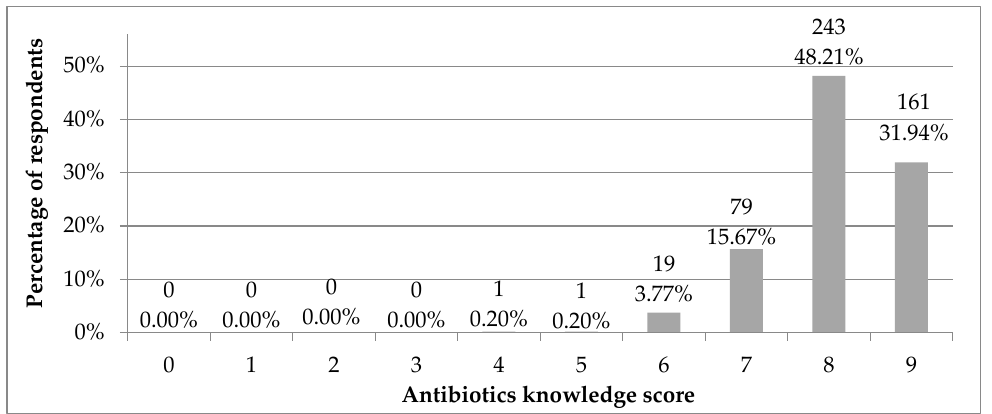
Figure 1. Antibiotics knowledge score (number of correct answers) in the study group ( N = 504). Scale from 0 — no correct answer to 9 — all the correct answers. Results are presented as the number and percentage of respondents.